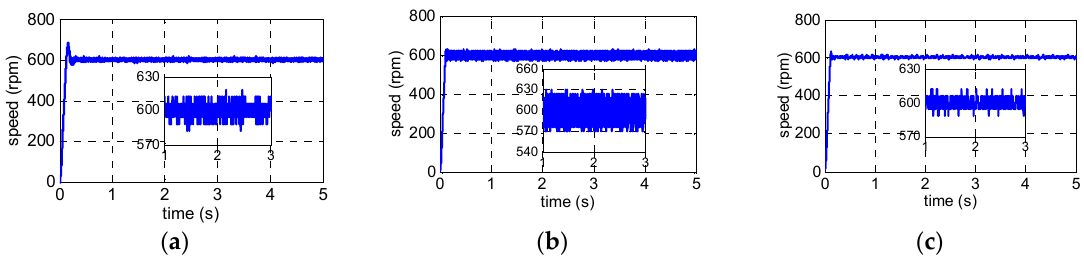
Figure 16. Experimental curves of rotor speed: ( a ) Under the PI method, ( b ) under the DMPC method with parameter mismatches by B 0 = 4 B and J 0 = 2 J . ( c ) Under the DMPC and EMSO methods with the parameter estimated value.